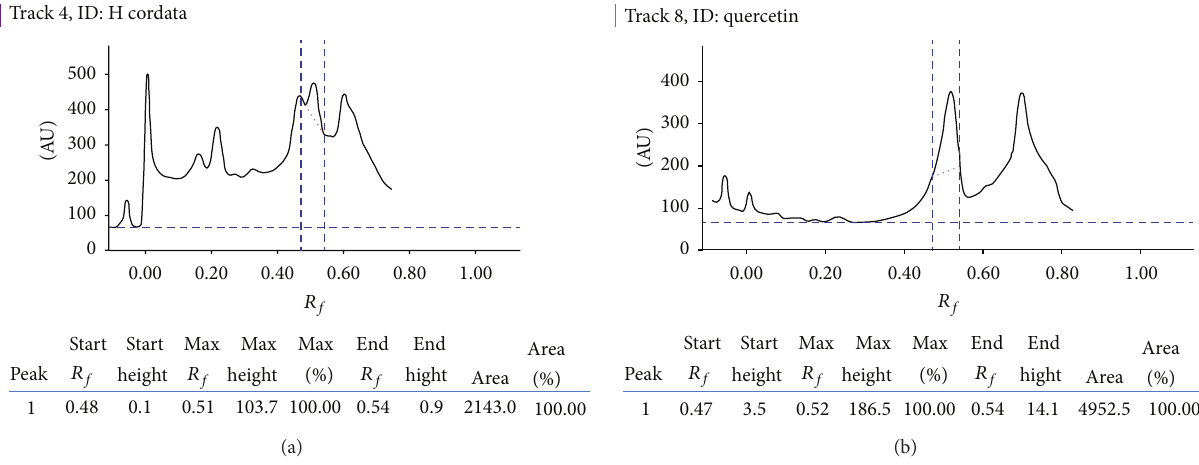
Figure 1: HPTLC densitogram of quercetin in ethanolic extract of H. cordata (HC). (a) Peak of quercetin present in HC and (b) standard peak of